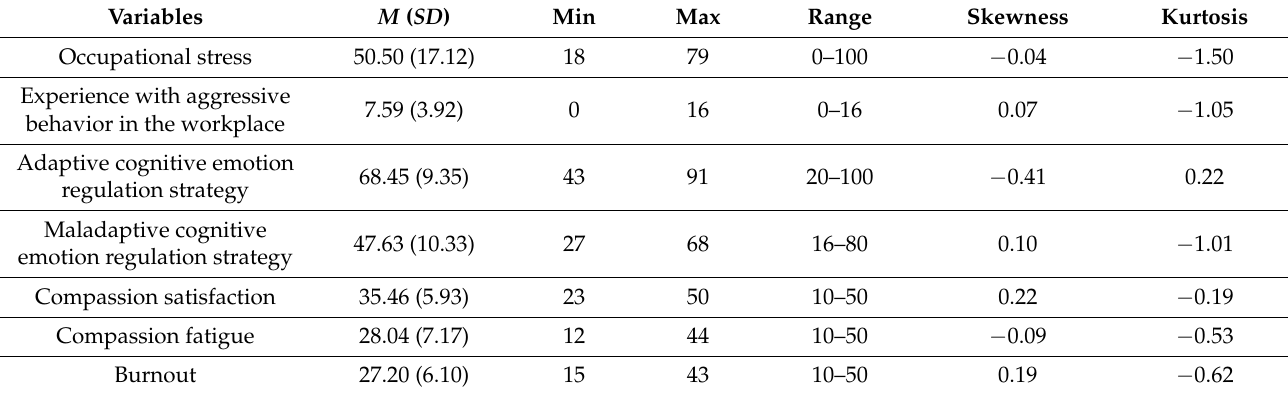
Table 1. Level of occupational stress, experience with aggressive behavior in the workplace, adaptive cognitive emotion reg- ulation, maladaptive cognitive emotion regulation, compassion satisfaction, compassion fatigue and burnout in community mental health professionals ( N =